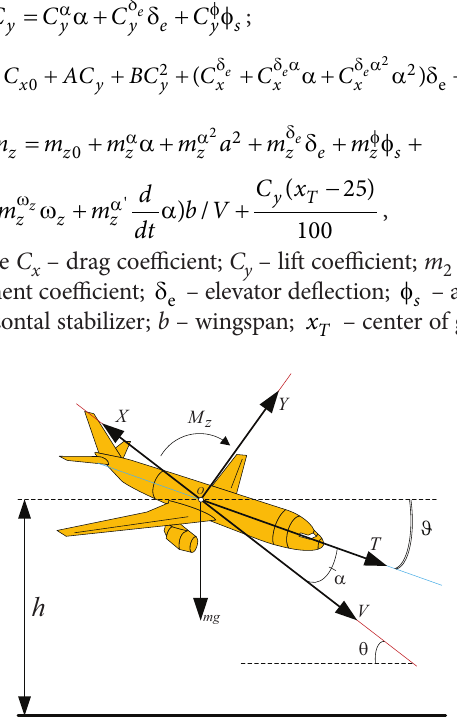
Figure 2. Forces and moments acting on an aircraft Figure 3. Altitude change